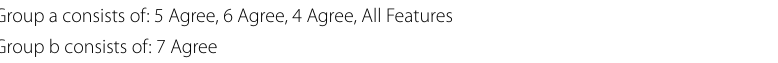
Table 16 HSD test groupings after ANOVA of AUPRC for the FST